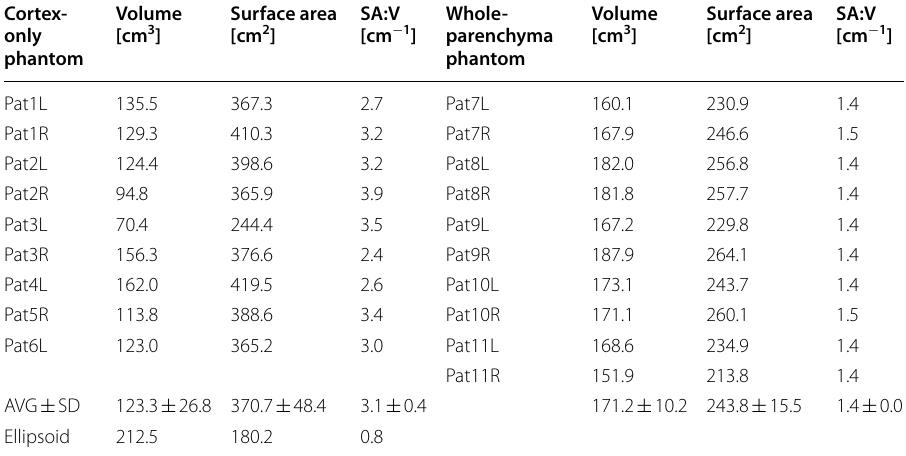
The last line lists the ellipsoidal phantom for comparison